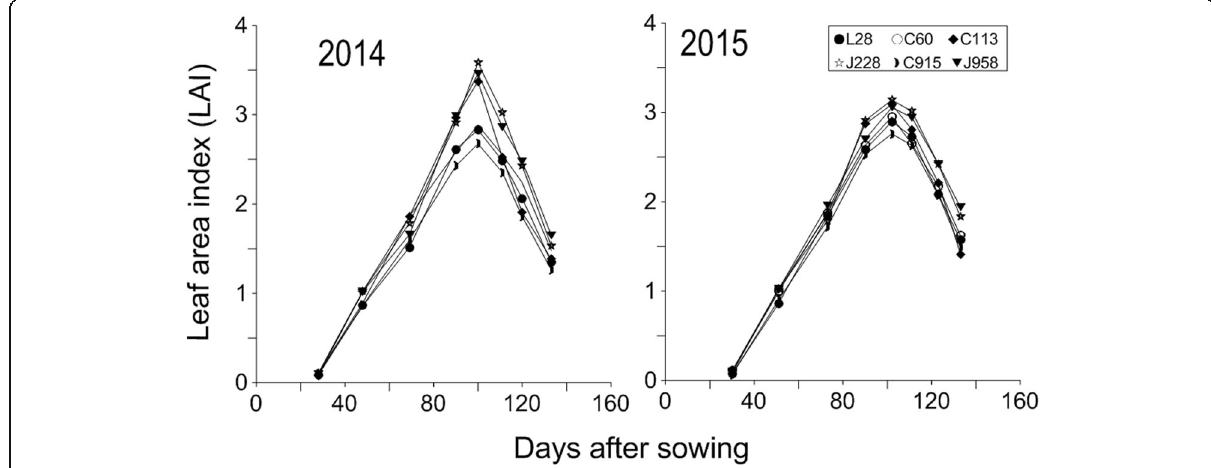
Fig. 5 Leaf area index (LAI) of six cotton varieties with different plant types during the cotton growth period in 2014 and